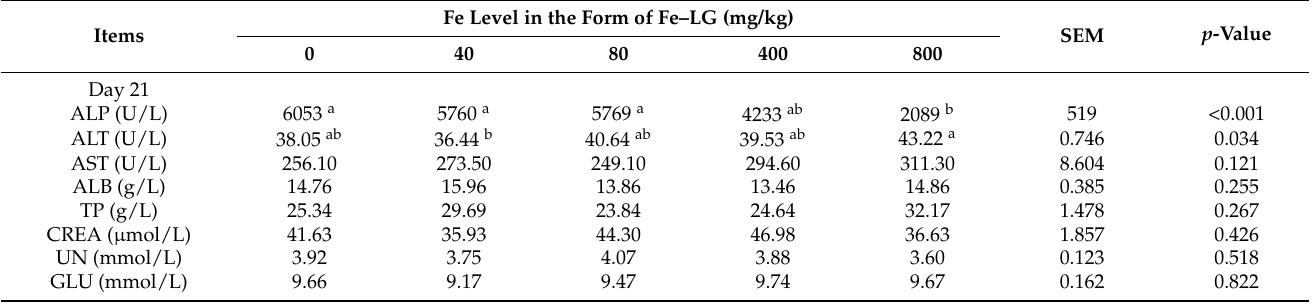
Table 8. Effects of dietary supplementation with high doses of Fe–LG on serum biochemical parame- ters of broilers 1